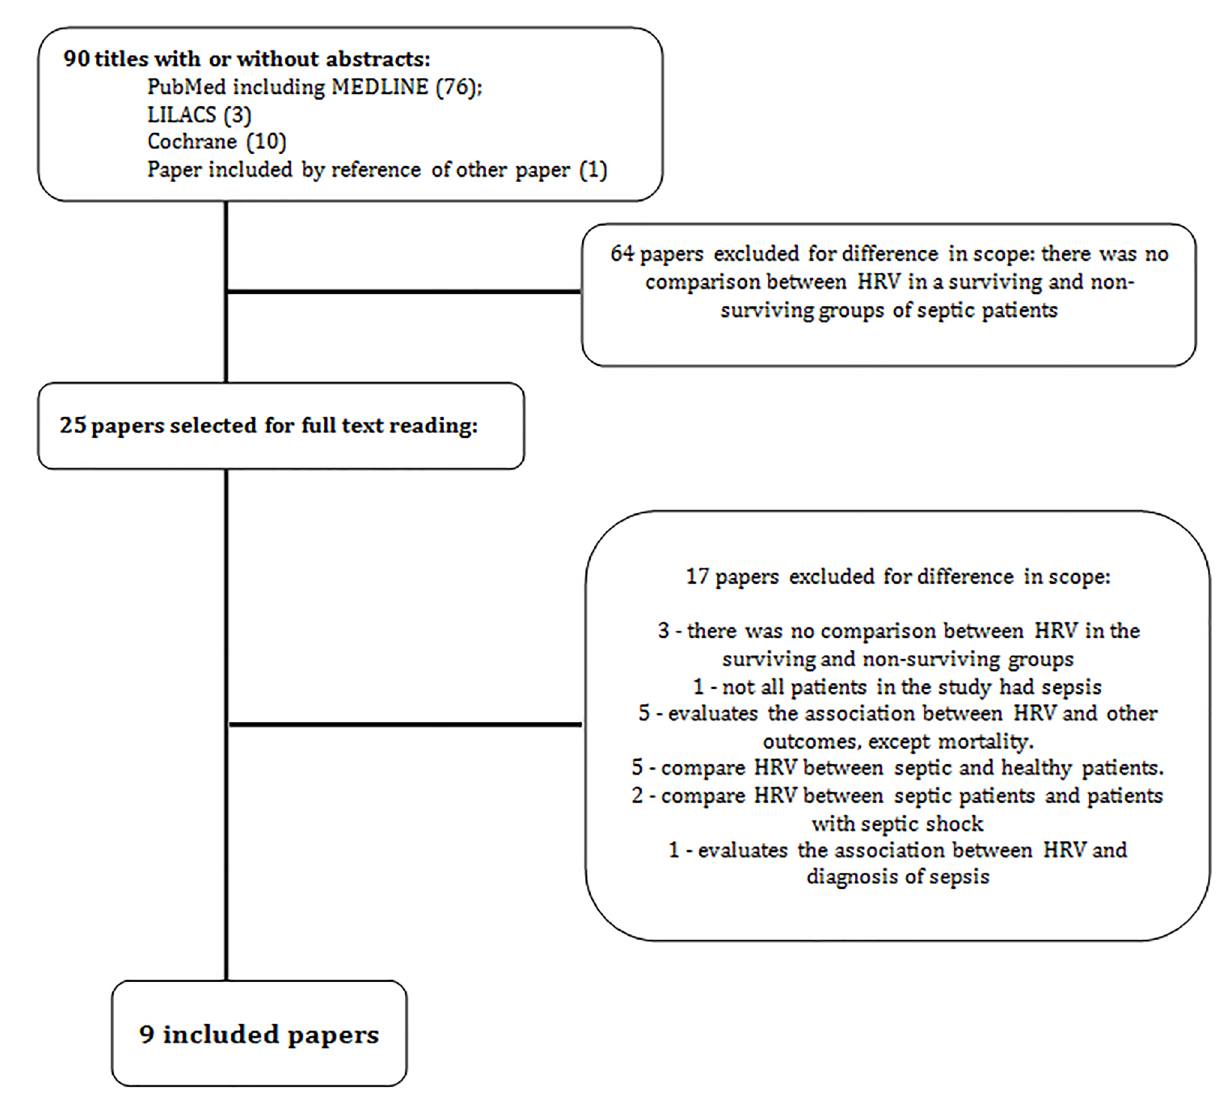
Fig 1. Inclusion flow of